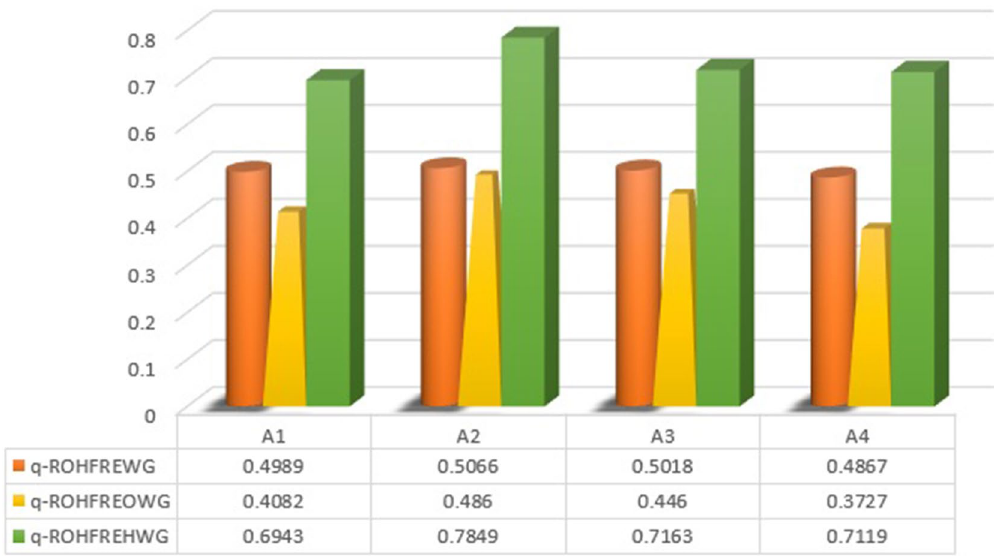
Figure 1. The graphical representation of ranking under proposed